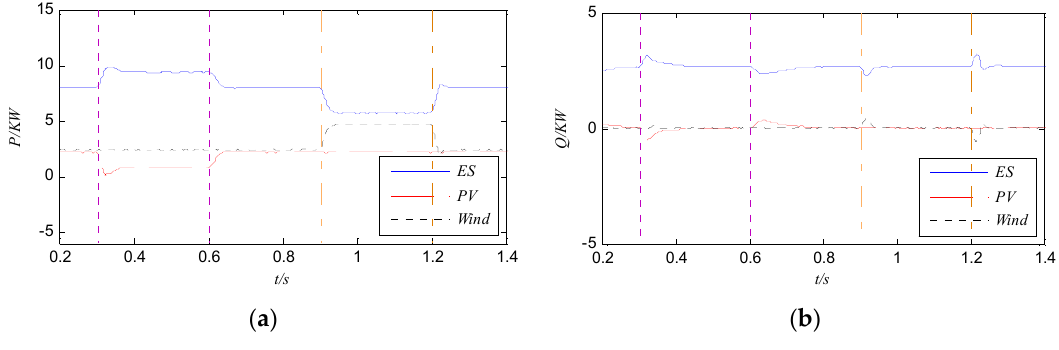
Figure 16. Active and reactive power output curves of micro ‐ source. ( a ) Active power output; ( b ) Reactive power output.